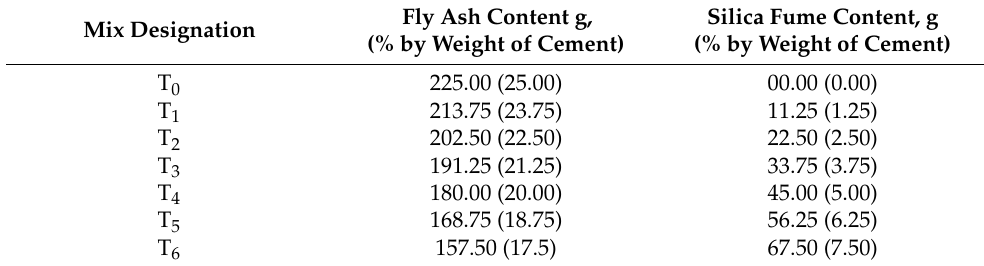
Table 2. Proportion of fly ash and silica fume